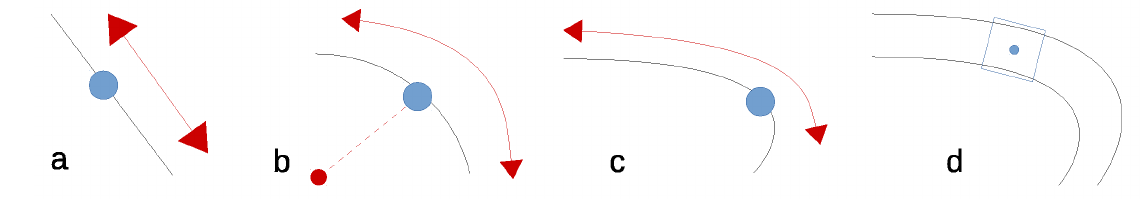
Figure 3. Constraints on ( a ) edge; ( b ) circular; ( c ) curve; ( d )